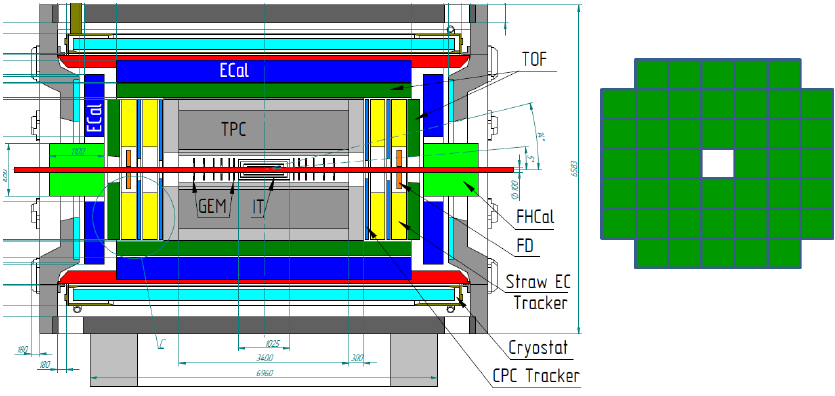
Figure 1. Left - the side view of the MPD experiment. Right - the modular structure of